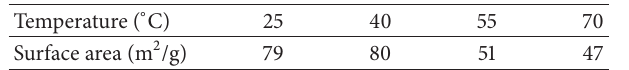
Table 3: Effect of temperature on the surface area of aluminium dross at reaction time of 15 minutes and concentration of NaOH at 1%.